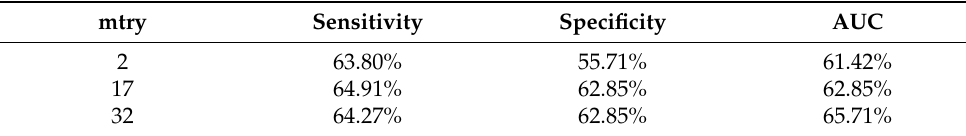
Table 3. Performance parameters for the model with 32 features.